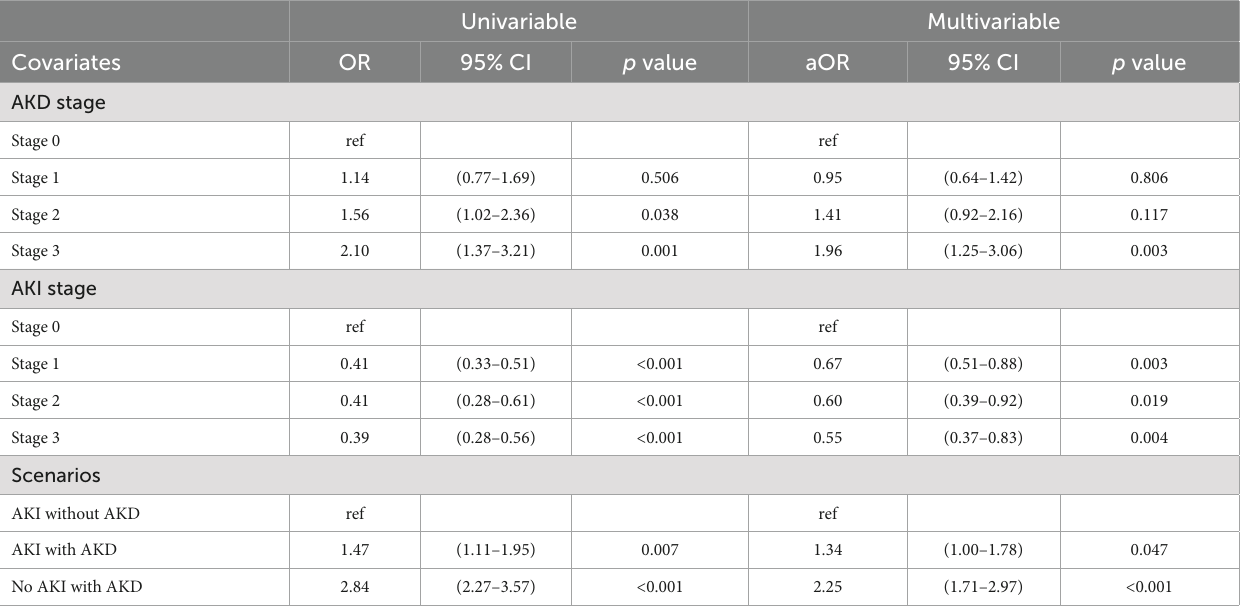
TABLE 4 Univariable and multivariate logistic regression of different combinations of AKD and AKI associated with 180-day mortality.